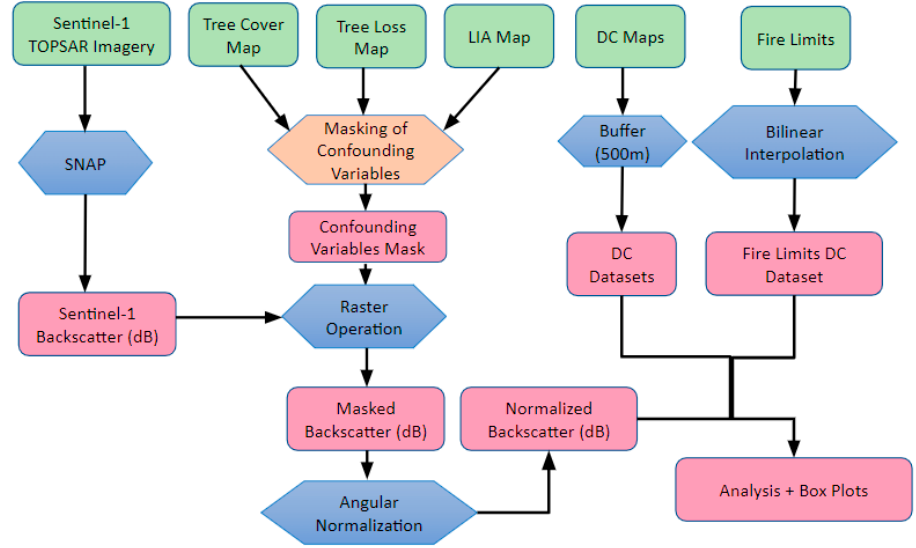
Figure 3. Flowchart describing the methodology used in the